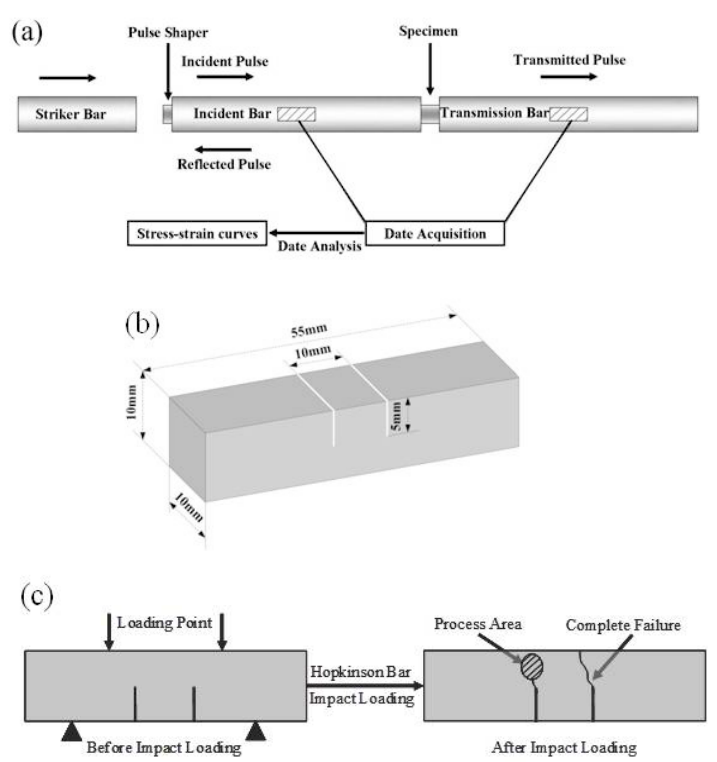
Figure 1. ( a ) Illustration of the Split Hopkinson Pressure Bar; ( b ) Dimensions of the specimens used in dynamic four-point bend tests; ( c ) Mechanism of the dynamic four-point bend tests used in this study.